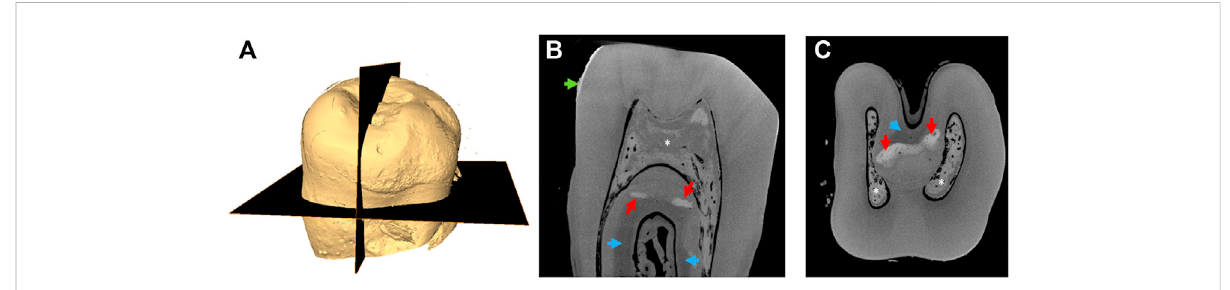
FIGURE 1 Micro-CT images ofan ERStooth (A) 3Dreconstruction basedon μ -CTimaging; theplanes analyzed areshown inblack. (B) Grayshademicro- CT imagefrom a sagittal section (vertical black plane of A). (C) Gray shade micro-CT image from a transverse section (horizontal plane of A). The red arrows indicate zones of increased mineralization. The blue ones indicate hypomineralized zones. The green arrow indicates pseudo enamel layer. Asterisks indicate calci fi cations in the pulp.